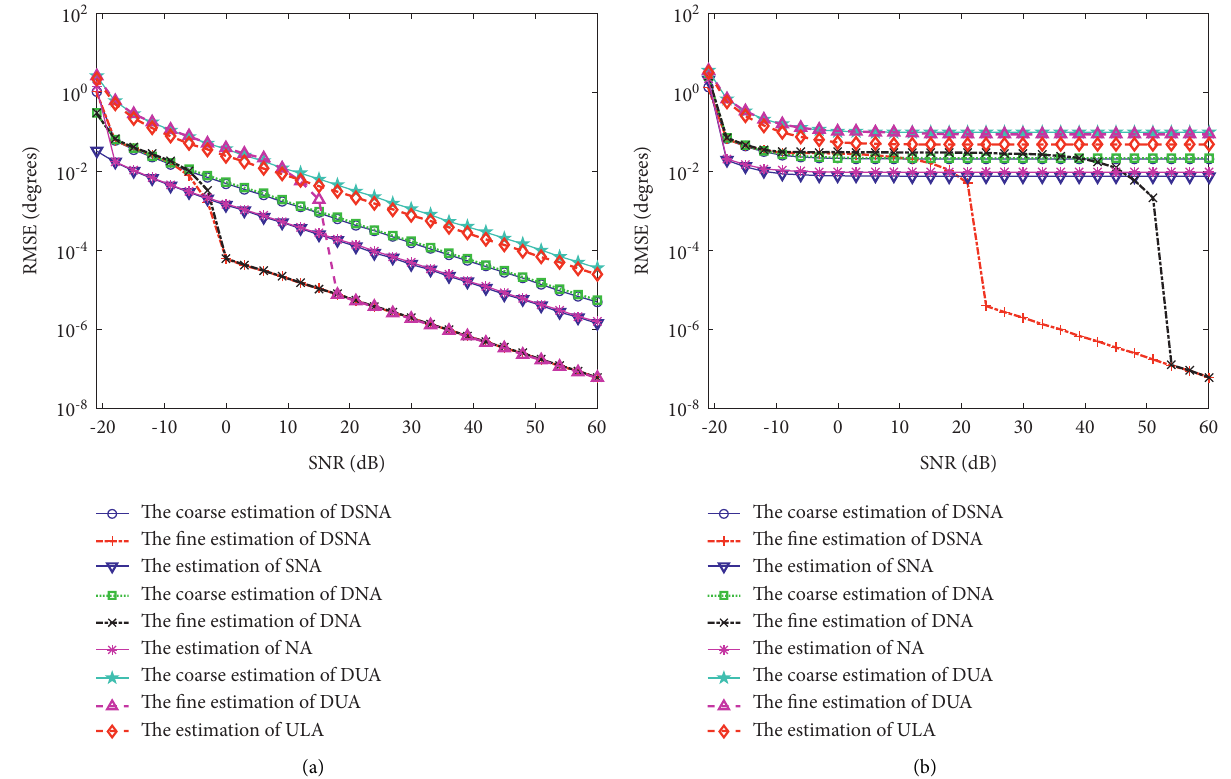
Figure 8: Single-source signal and d � λ /2; the baseline length is 1500 times the wavelength. (a) Not considering mutual coupling between the array antennas. (b) Considering mutual coupling between the array